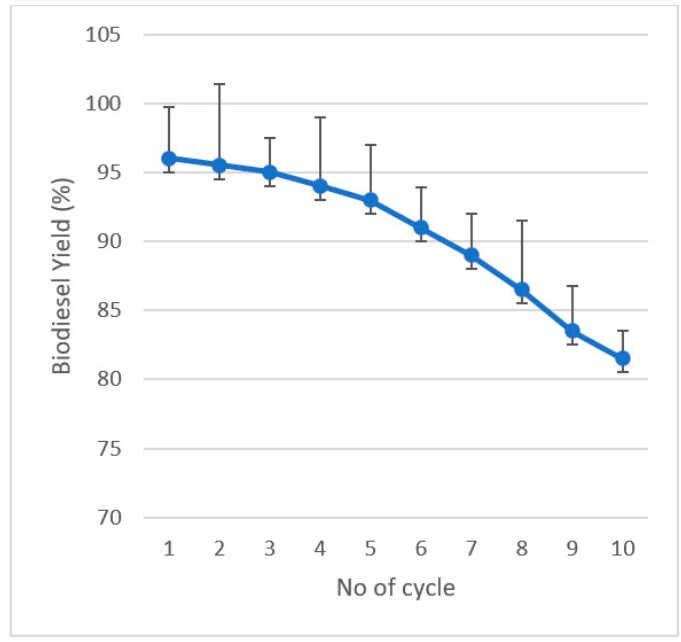
Figure 5. Reusability test of the 20Ca/AC-650 catalyst.